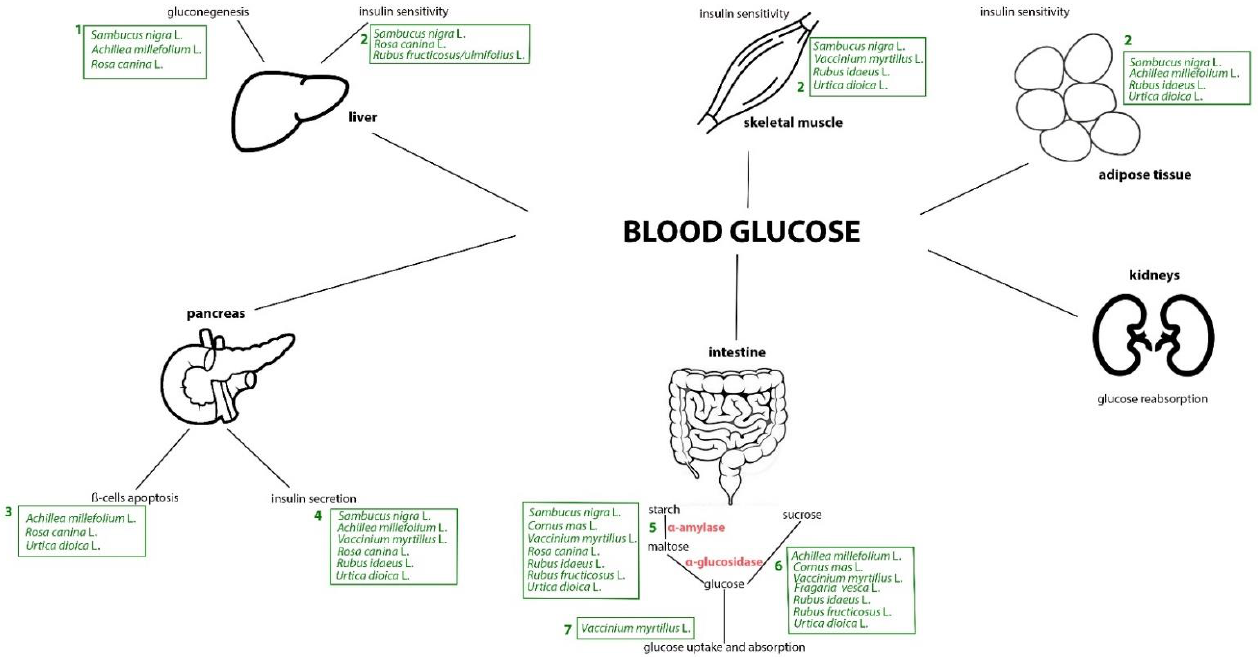
Figure 1. Plants used in the Occitan valleys of the Piedmont Alps: target tissues of their anti-diabetic effects. The selected plants have been suggested to reduce blood glucose levels by acting on various organs and tissues involved in glucose homeostasis. According to the experimental evidence published between 2011 and 2021 they can be grouped into plants promoting: 1 = gluconeogenesis downregulation; 2 = insulin sensitivity increase in liver, skeletal muscle and adipose tissue; 3 = islet atrophy inhibition and/or pancreatic β -cells regeneration promotion (associated with a reduction of inflammatory disease and increased proliferation); 4 = insulin secretion from pancreatic β -cells; 5 = α -amylase inhibition; 6 = α -glucosidase inhibition; 7 = reduction of glucose uptake from the intestinal epithelium.